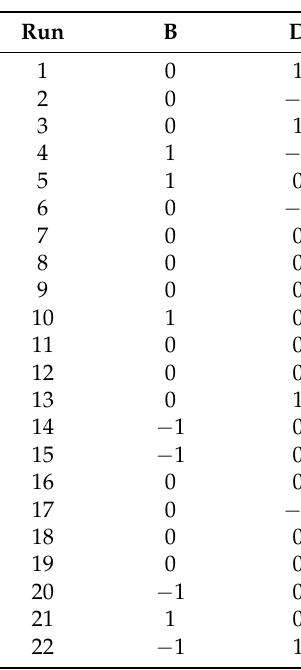
Table 5. BBD experiment